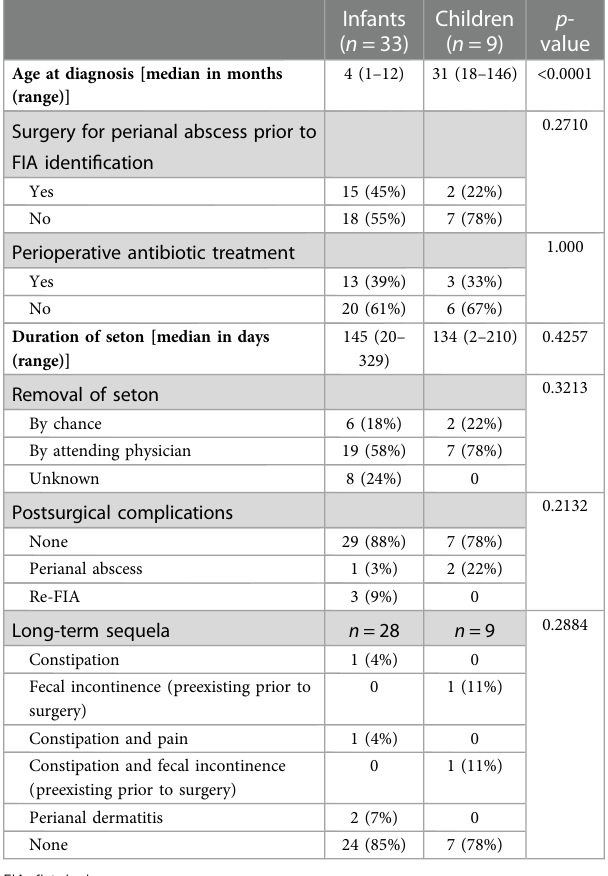
TABLE 2 Surgical characteristics and outcome concerning age groups (infants<12 months vs. children>12